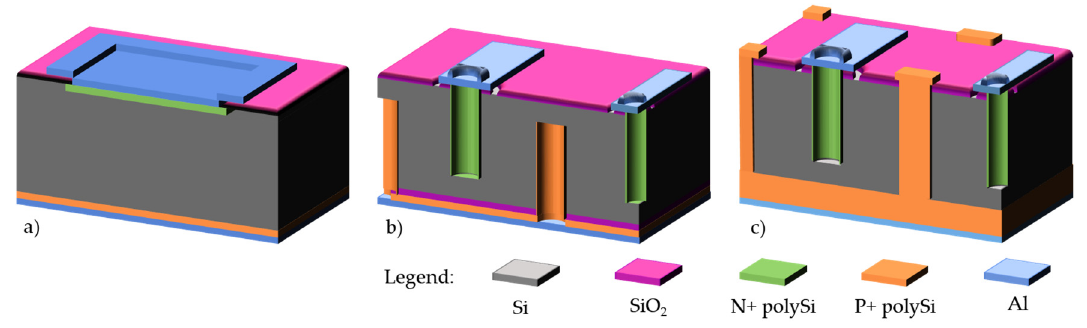
Figure 1. Comparison between different geometry of silicon radiation detectors: ( a ) planar, ( b ) 3D double-side, and ( c ) 3D-SiSi fabricated from Si-Si wafers.